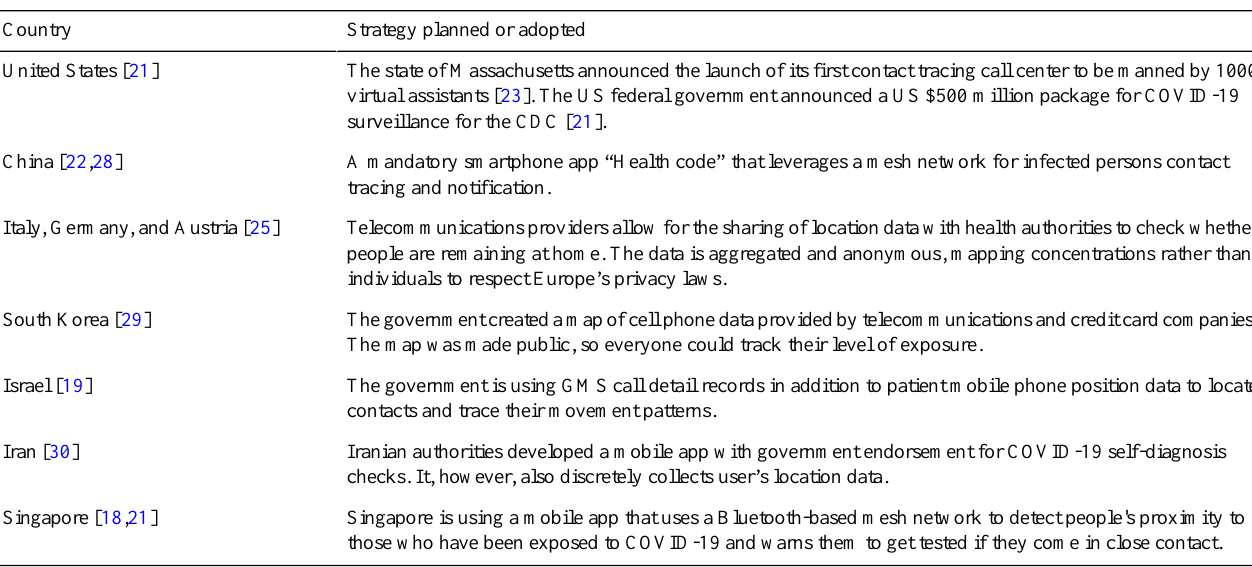
Table 1. Strategies planned or adopted by countries for the use of mobile positioning data in response to the COVID-19 pandemic. Strategy planned or